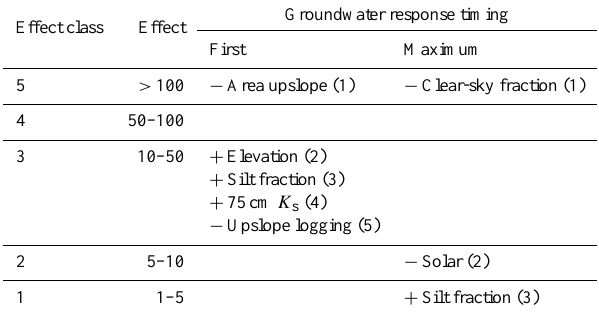
Table 5. Effect class, strength of the effect, direction of the effect (positive or negative), and effect rank (indicated numerically to the right of the variable name) for the variables in the logistic regression models predicting groundwater response timing (first and maximum responses over the annual period). The effects were calculated as the exponential of the following product: the coefficient for the predic- tor variable multiplied by the range in the data between the 25th and 75th percentile values for the